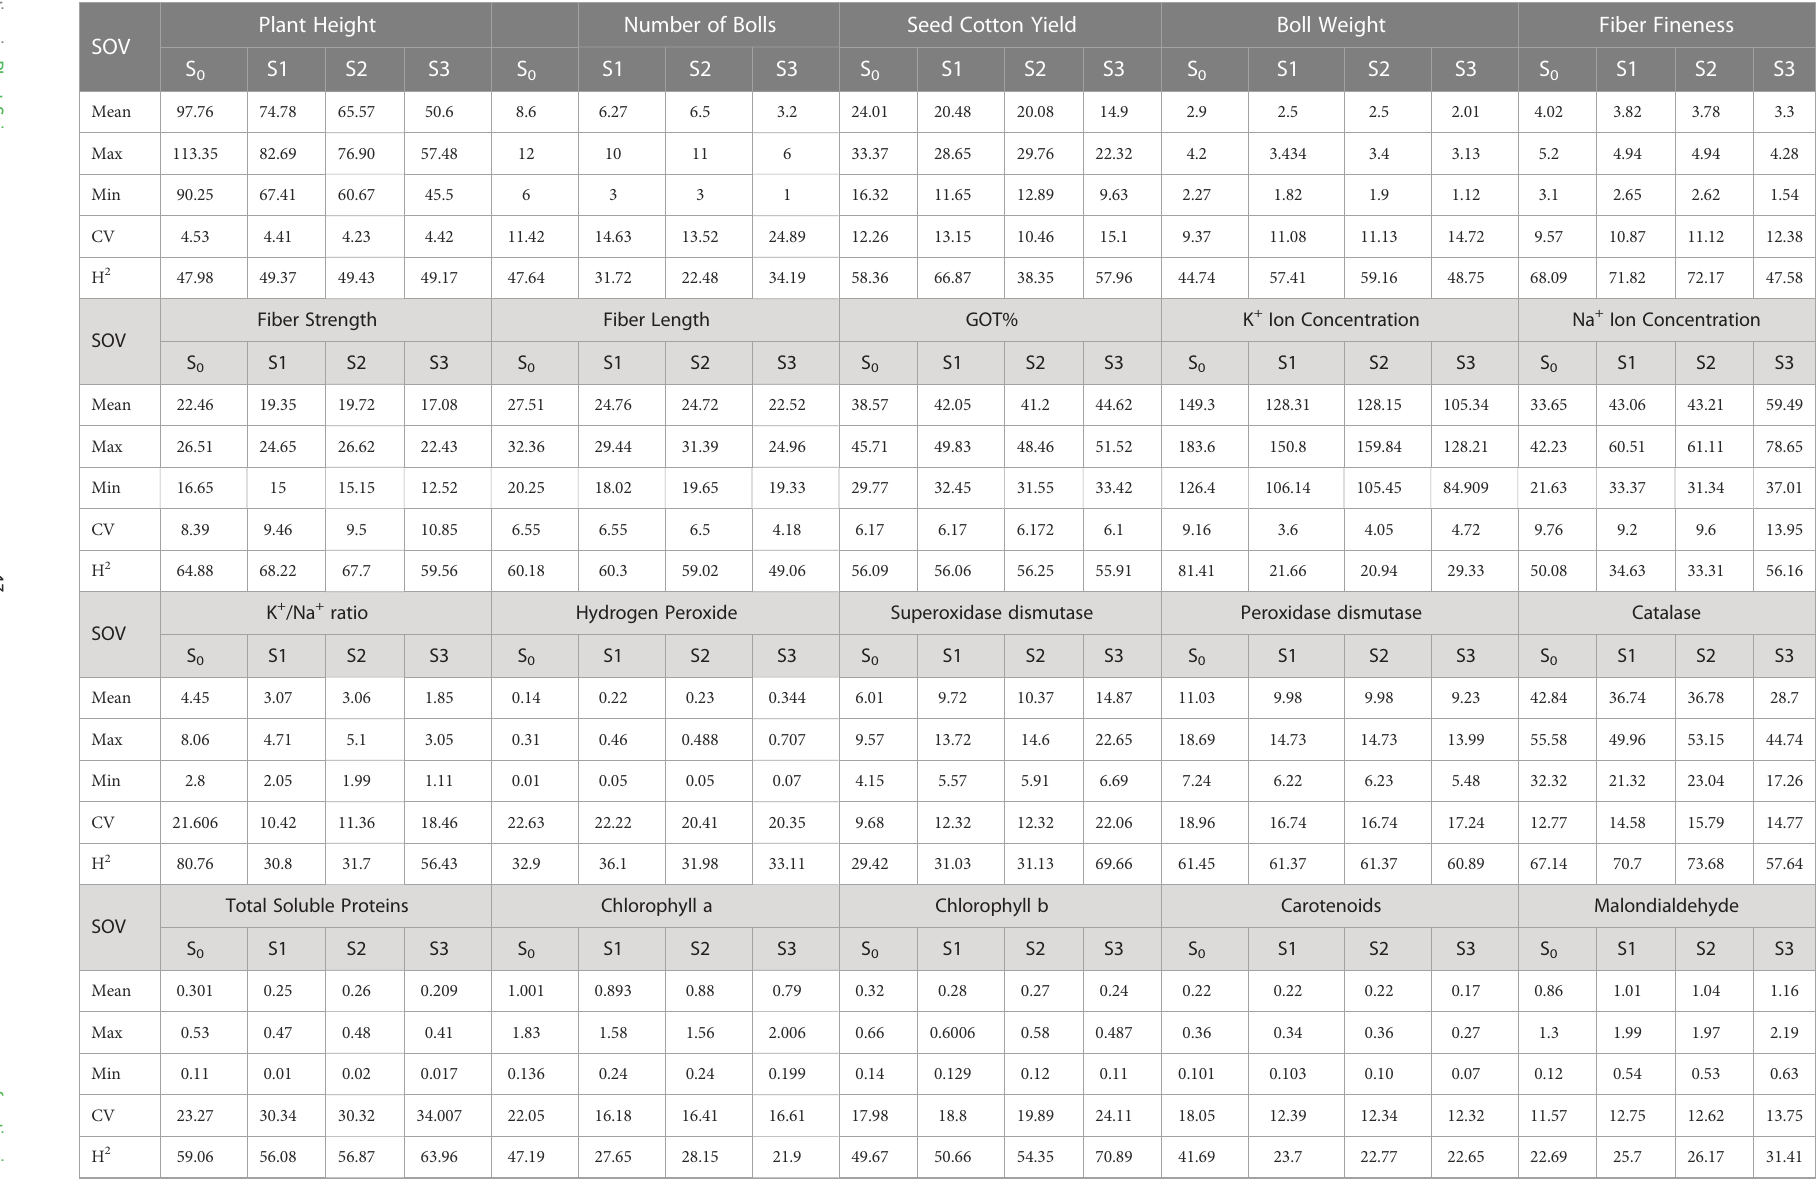
TABLE 3 First year components of variability and heritability of various traits under control and stress conditions. Plant Height Number of Bolls Seed Cotton Yield Boll SOV